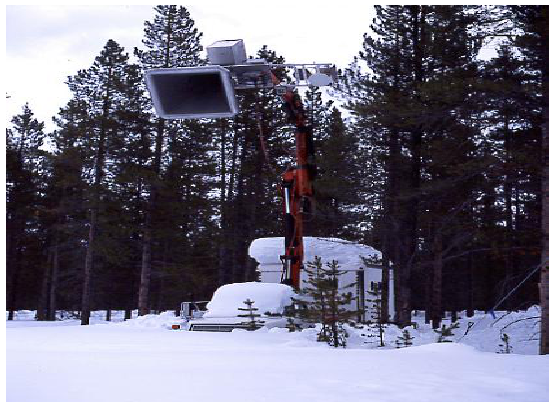
Figure 1 . L and Ku band radar at Fraser (Saint-Martin et al, 2003)